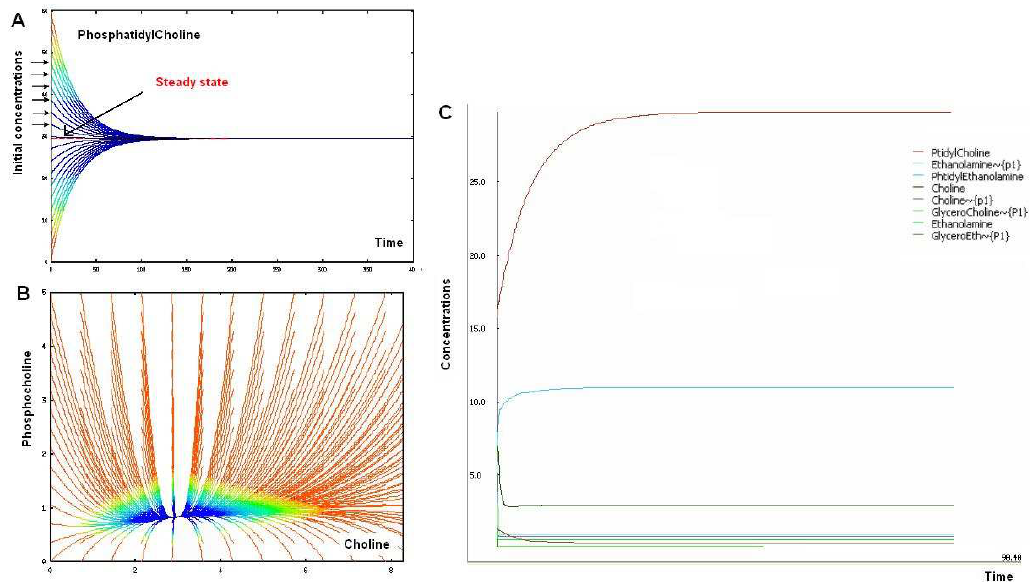
Figure 2: Changes in initial concentrations. A: Changes of initial concentration of Phosphatidyl- Choline. B: Phase space for Choline and PhosphoCholine. C: An Example of different initial concentrations traversing into steady state. In A and B the color change from red to blue refers to approaching the steady state. In C each color associates to the concentration of one of the reactants. Concentrations values are given in µmol.g − 1